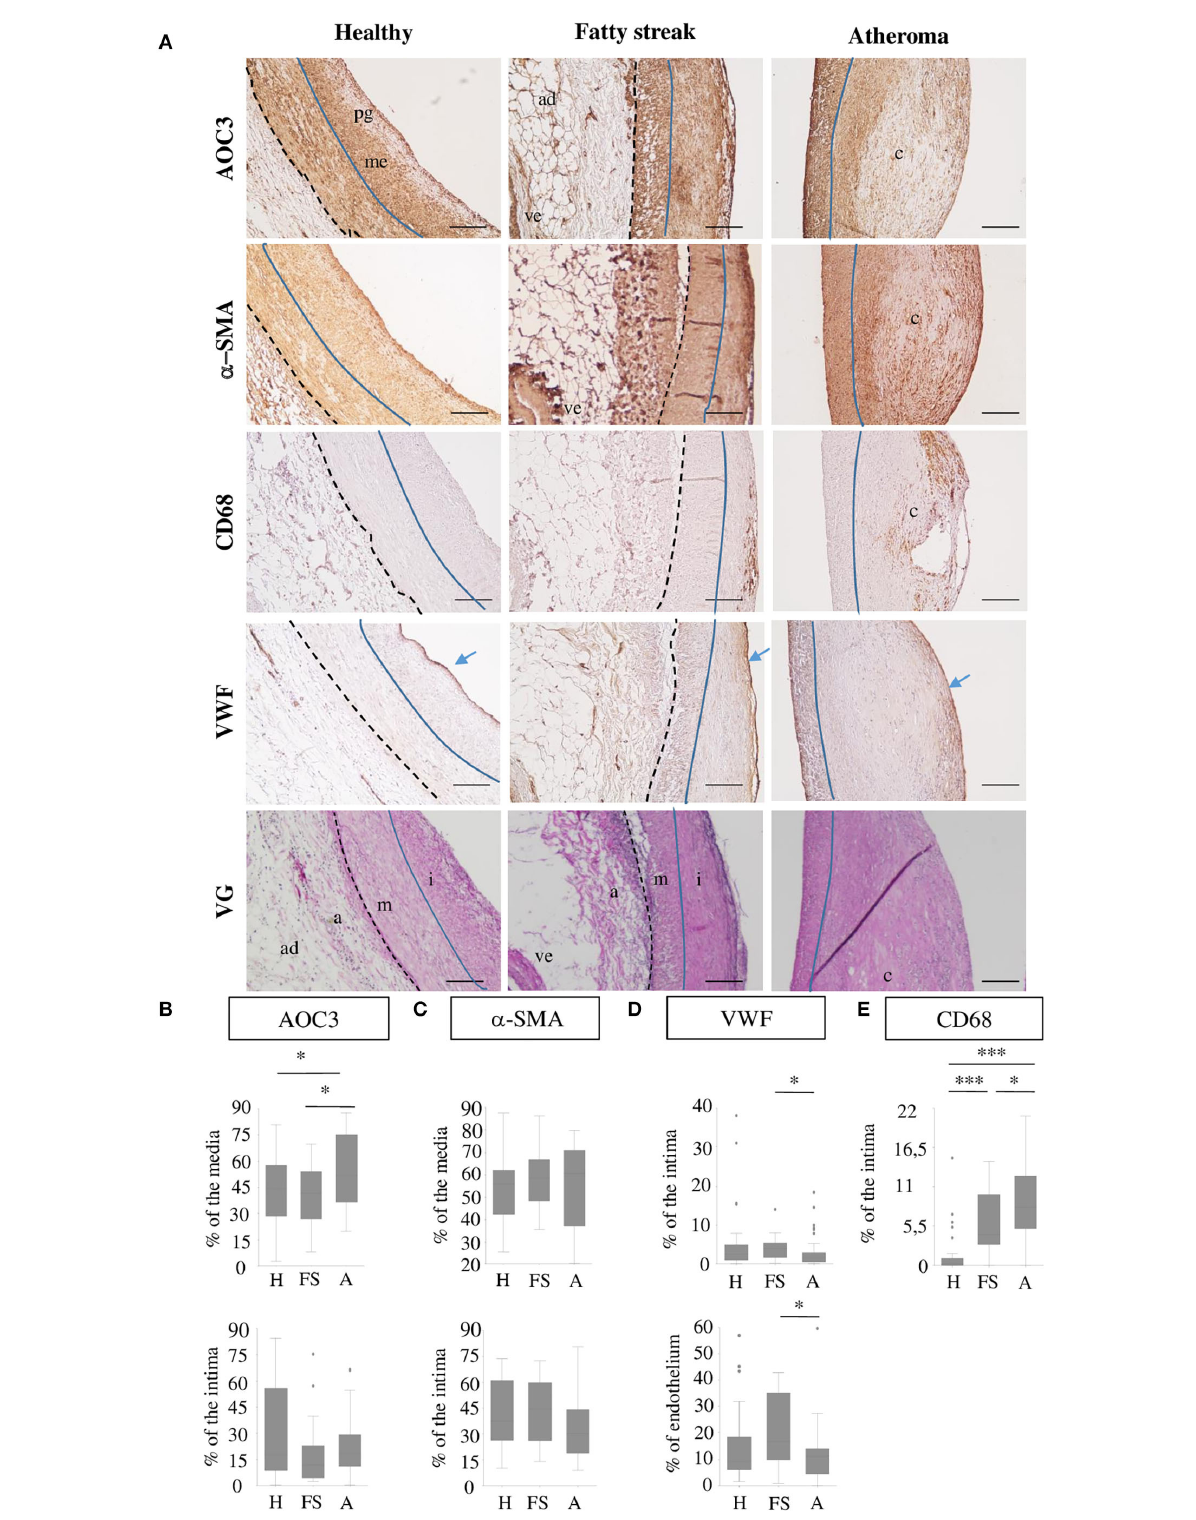
FIGURE4 AOC3 in human coronary arteries. (A) Representative pictures from immunohistochemistry for AOC3, α -SMA, CD68, and VWF are shown on consecutive healthy (H), fatty streak (FS) and atheroma human carotid sections. An Elastica Van Gieson (VG) staining from consecutive